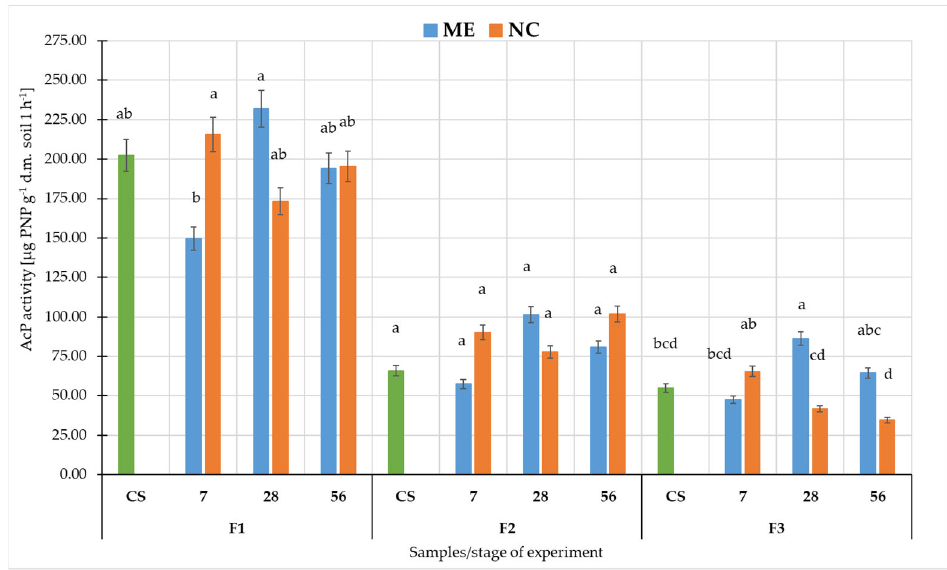
Figure 6. Activity of acid phosphatases (AcP) in fluvisol. Different lower ‐ case letters “a–e” indicate significant differences for the same soil sample in different experimental variants (control, simulated flooding, natural flooding) at p < 0.05 (Tukey HSD test; n = 9). Explanation of the samples in Table 1.